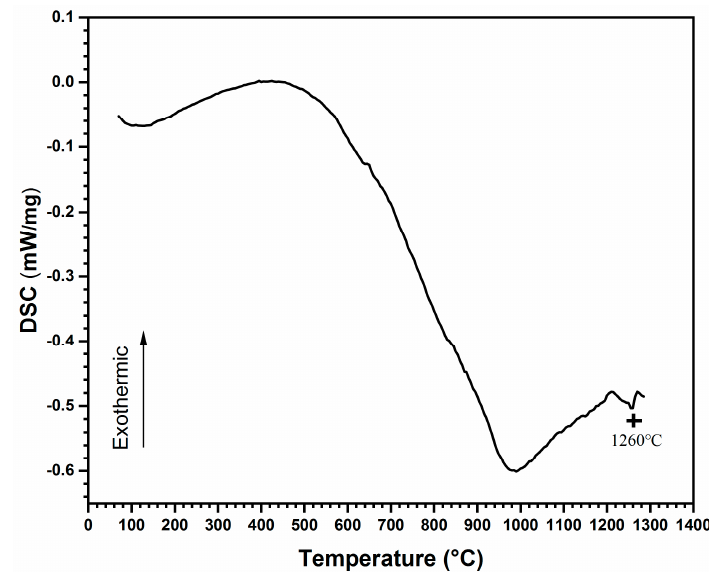
Figure 7. Differential scanning calorimeter (DSC) of the FeCoCrNiMo HEA sample processed by SPS.